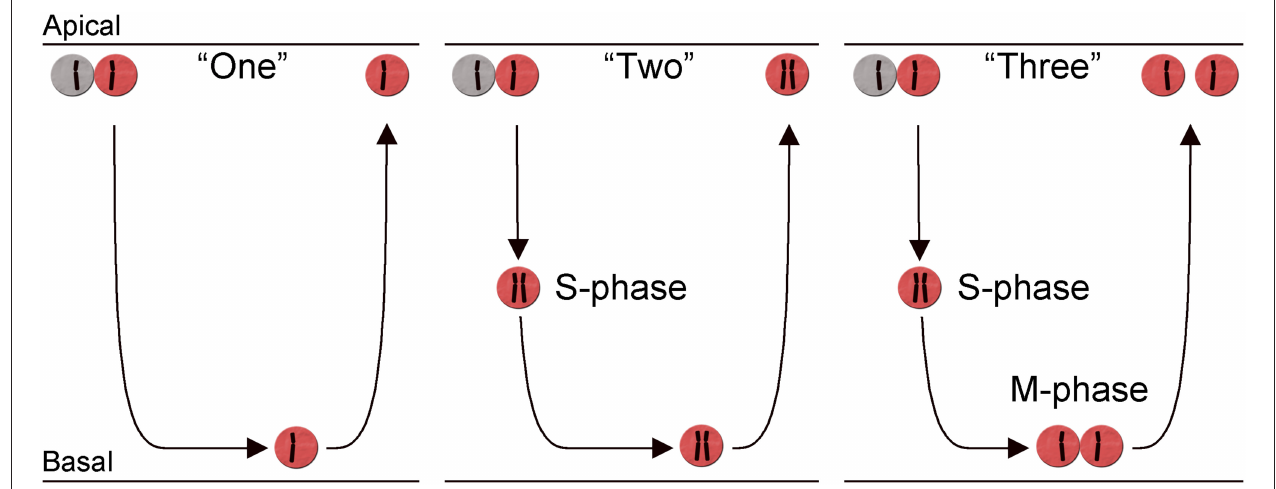
FIGURE 3 | Heterogeneity in the terminal cell division of horizontal cells. Schematic diagram showing three different behaviors during the neurogenic cell division of chicken horizontal H1 (Lhx1 + ) cells. The diagram illustrates the retina with mitosis (M-phase) and S-phase indicated in relation to the migration across the retina. The migration is indicated by the arrows and the replicated state of each cell, in the three behaviors is indicated by a schematic chromosome. Two chromosomes indicate a cell with replicated DNA. The three different behaviors are denoted: behavior “One,” “Two,” and “Three” in the main text.